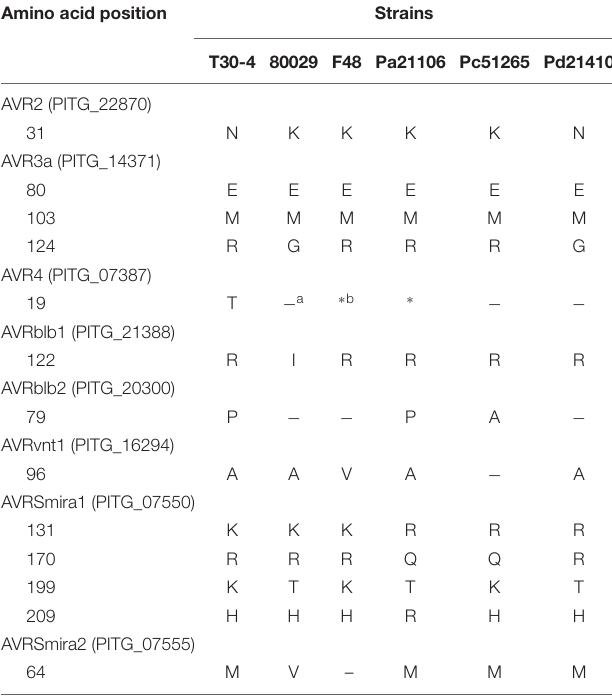
TABLE 3 | Amino acid substitutions in the known RXLR effectors (AVR). Amino acid